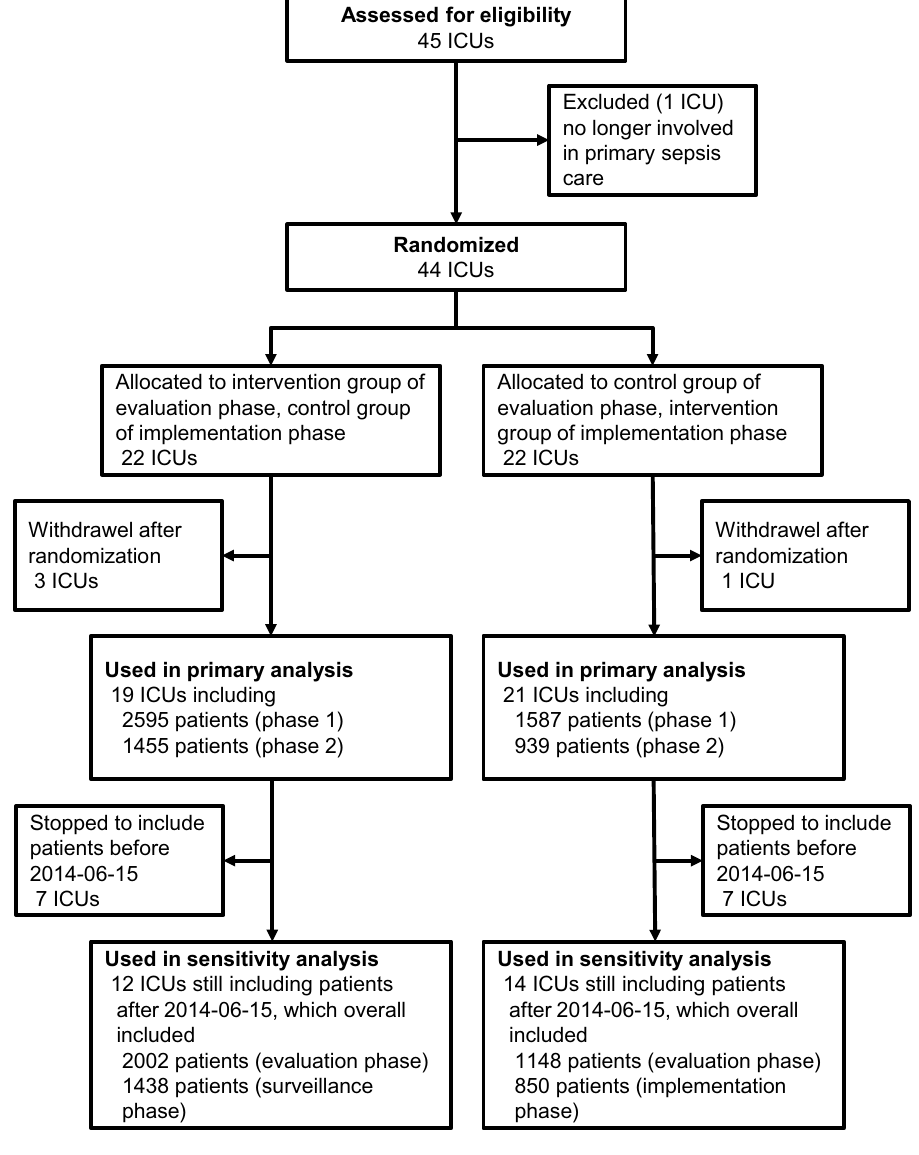
Figure 1. Inclusion of hospitals and